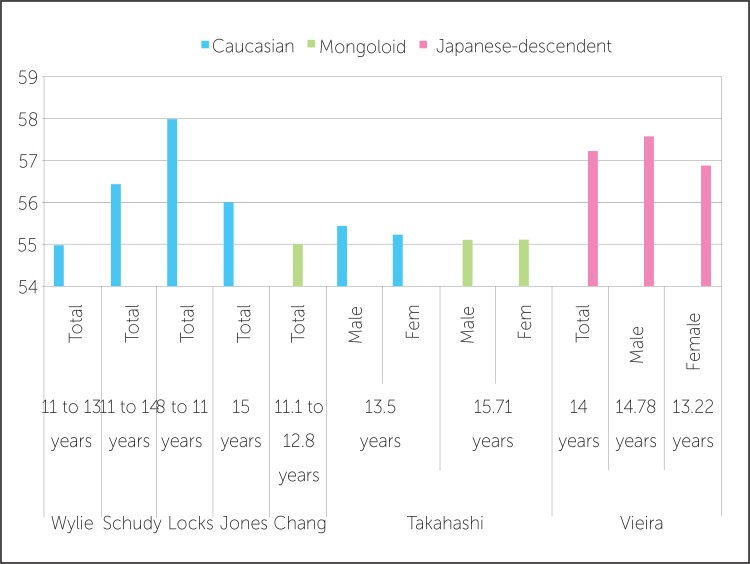
Means of LAFH - TAFH.